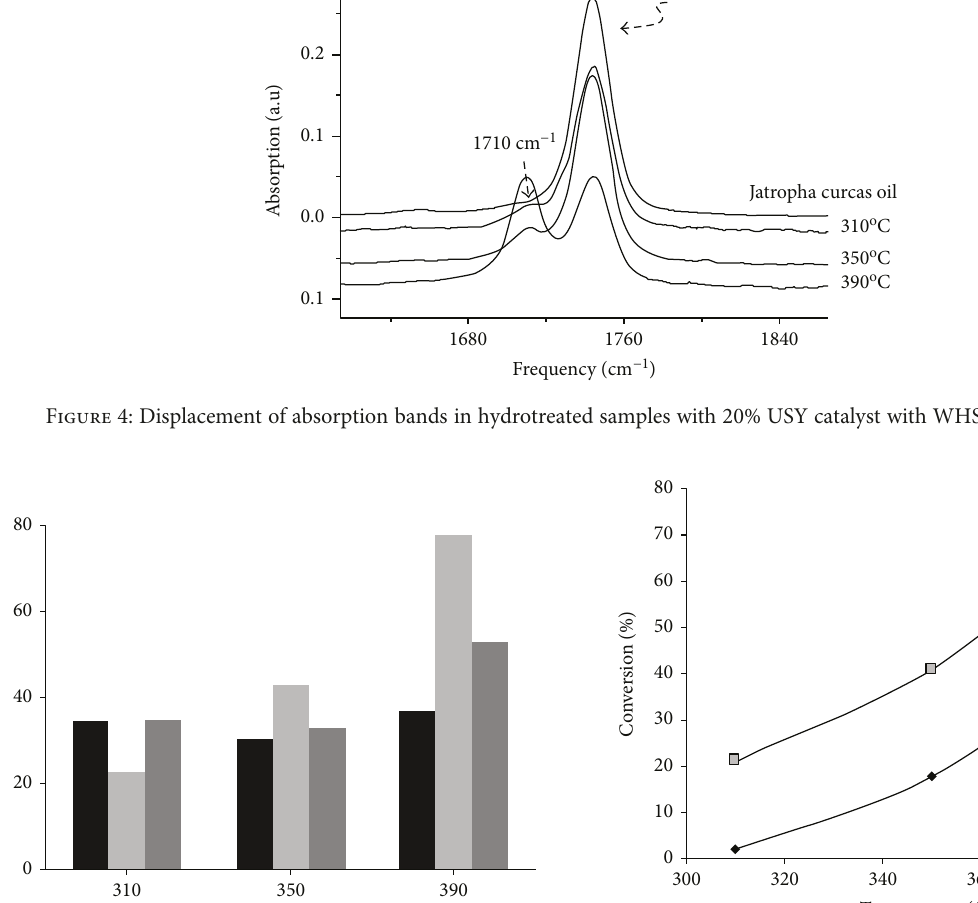
O at WHSV =35.28h − 1 2 3